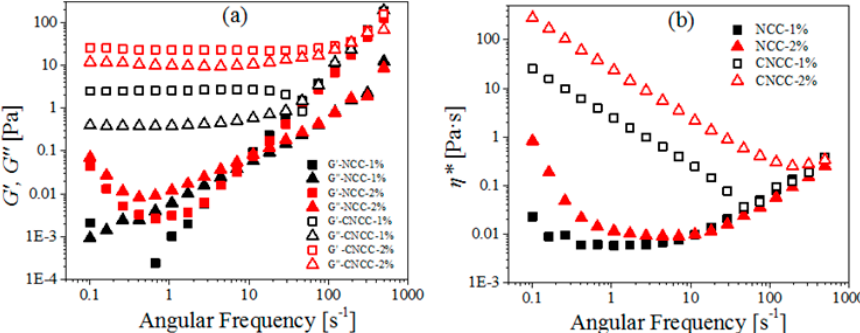
Figure 8. ( a ) G ’, G ″ , and ( b ) η * as a function of angular frequency for NCC and CNCC suspensions at different concentrations (1, 2 wt %).